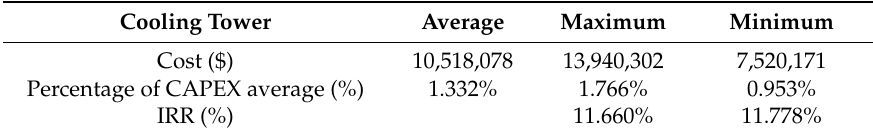
Table 6. IRR according to cooling tower cost.